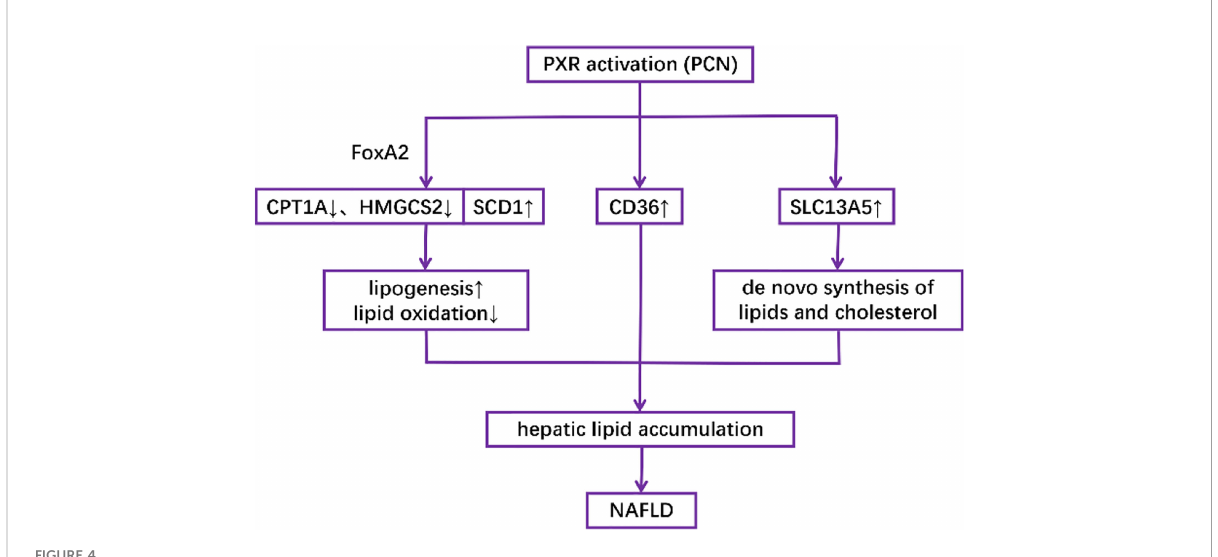
FIGURE 4 Mechanisms underlying the role of PXR activation in the pathogenesis of